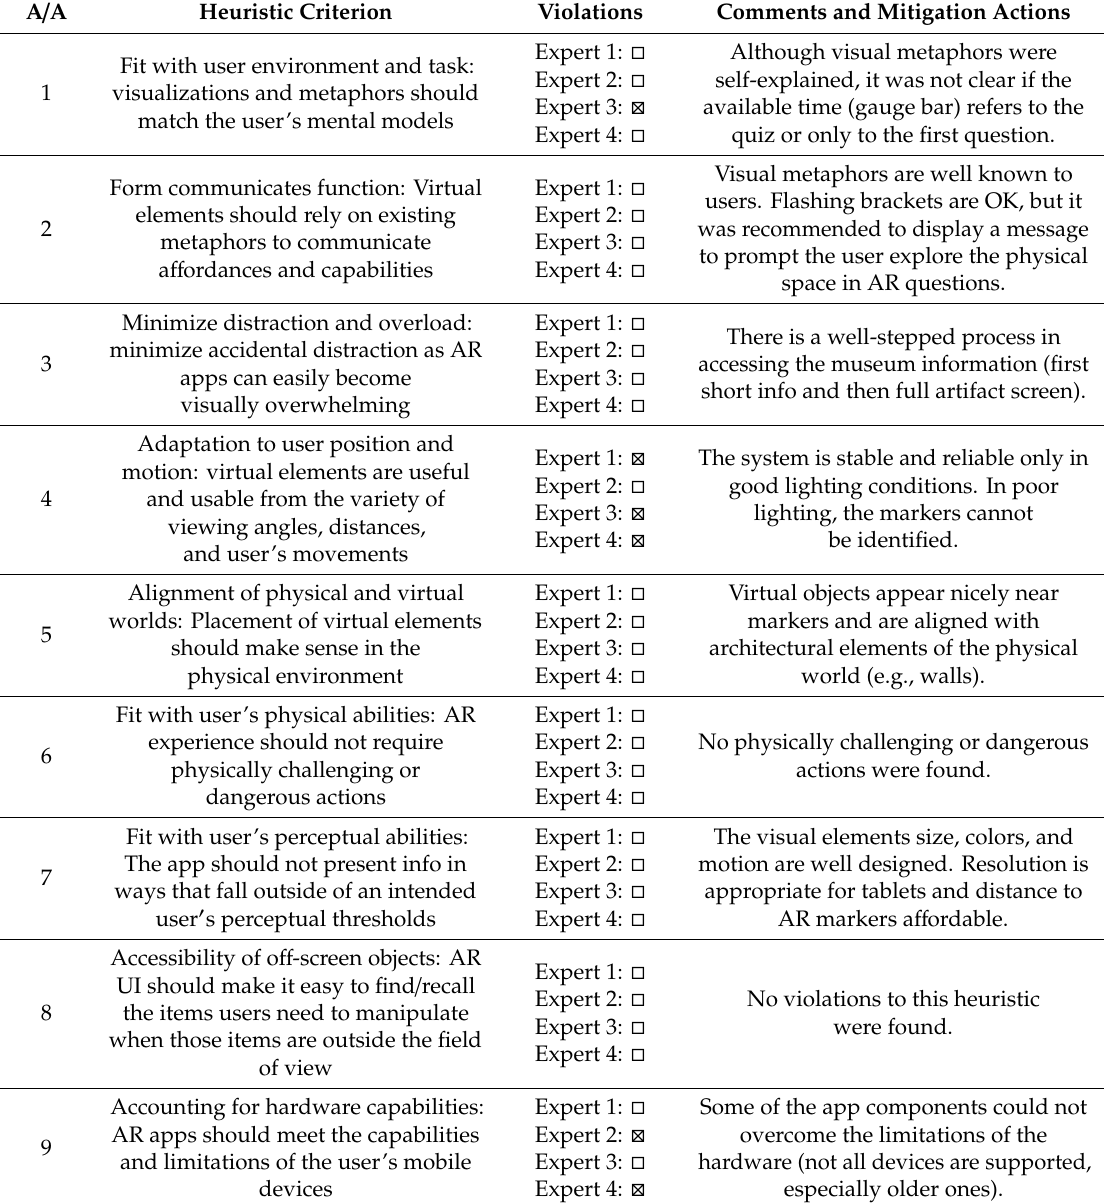
Table 1. Heuristic evaluation criteria for AR [46] and experts’